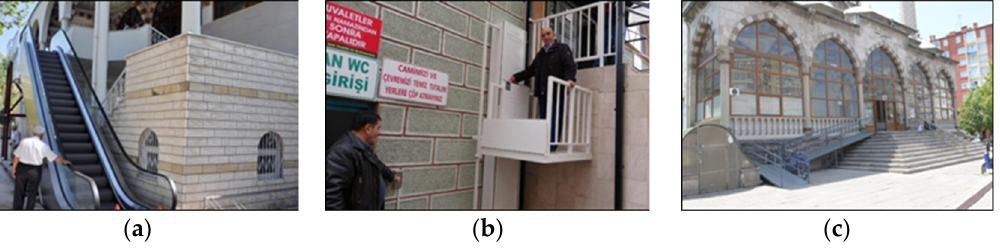
Figure 20. ( a ) Meltem Mosque, escalator solution; ( b ) Green Mosque, elevator solution; ( c ) Melikgazi Mosque, ramp solution.